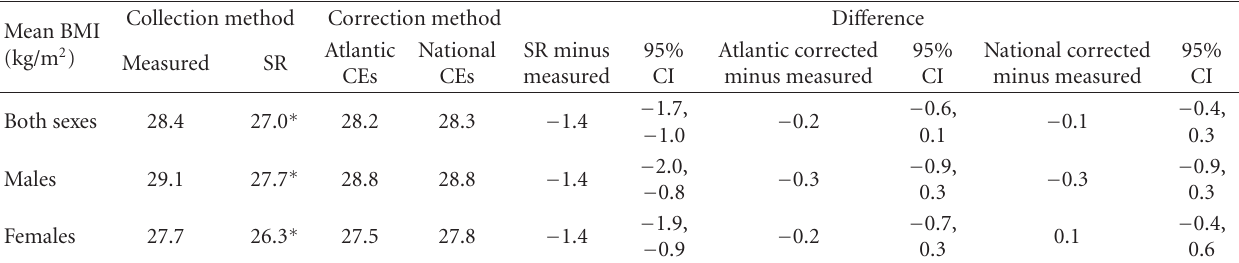
Table 2: Mean body mass index (BMI) and mean di ff erence between measured and self-reported or corrected BMI, by collection method and sex, household population aged 18 years or older, Atlantic Canada, 2007-2008. Mean